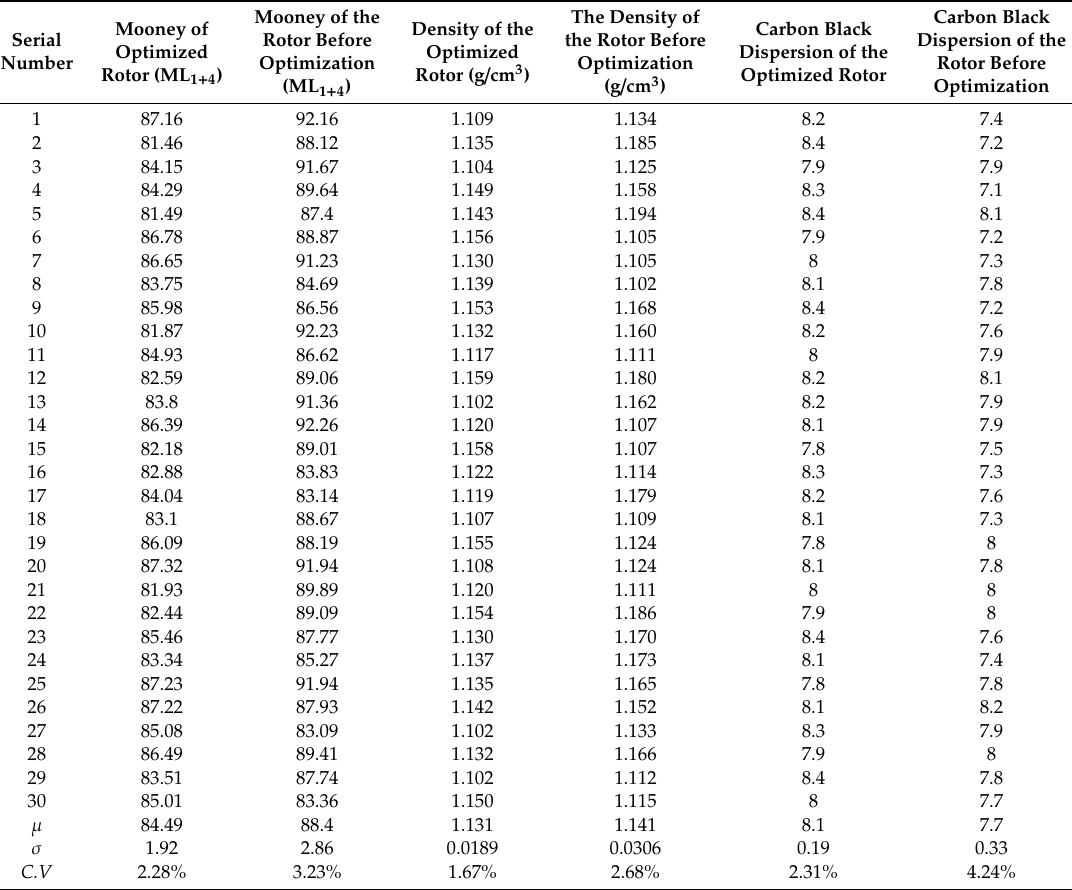
Table 6. Experimental data from the synchronous rotor before and after